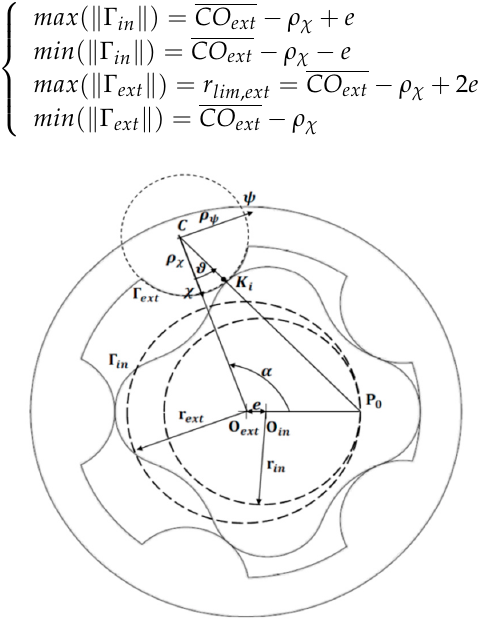
Figure 3. Gerotor profile generation.